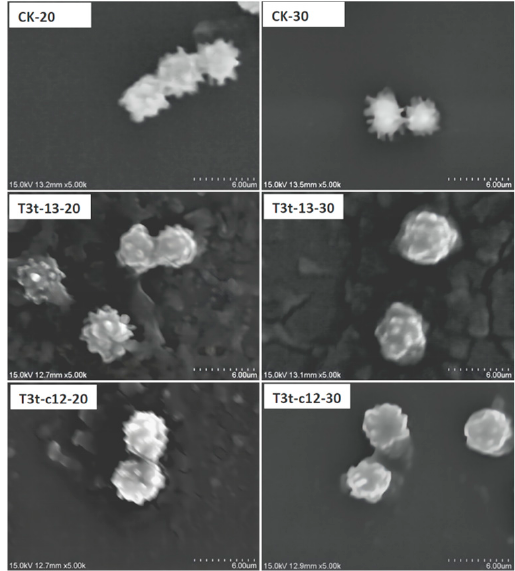
Figure 8. Morphology of A. niger A1513 spores with thermo-responsive AZO-loaded NP treatment under SEM. CK-20 and CK-30 were A. niger A1513 spores air-dried at 20 °C and 30 °C, respectively; T3t-13-20 and T3t-13-30 were A. niger spores air-dried at 20 °C and 30 °C, respectively, after co- incubation with T3t-13 NPs; T3t-c2-20 and T3t-c2-30 were A. niger spores air-dried at 20 °C and 30 °C, respectively, after co-incubation with T3t-c2 NPs.